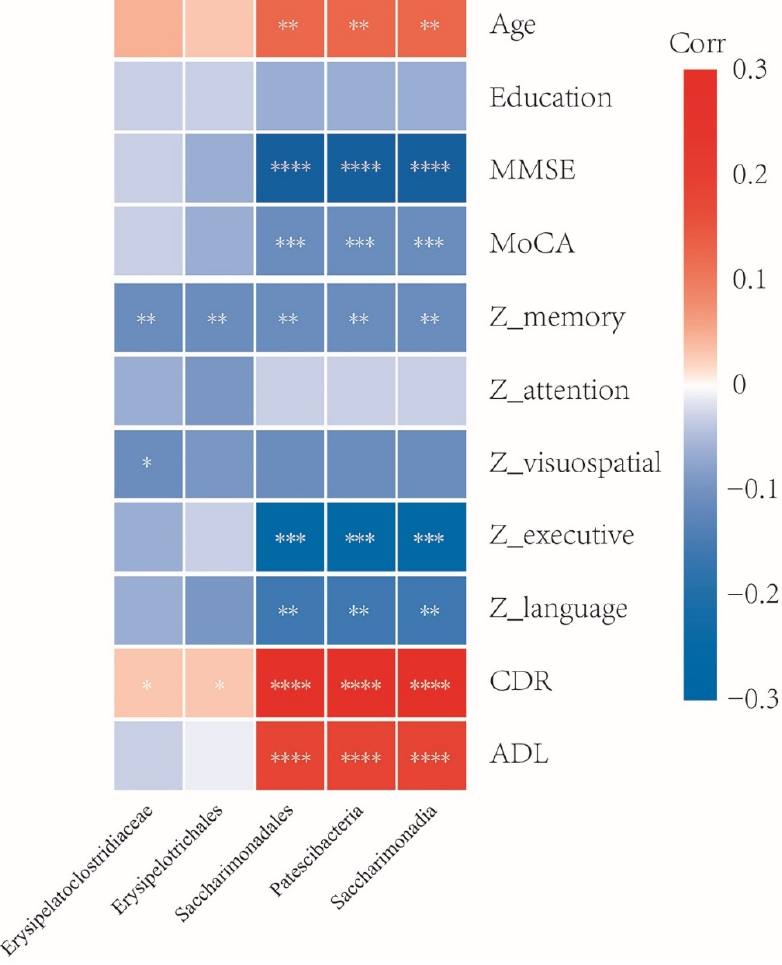
Figure 4. Correlations between the five specific taxa and clinical characteristics. The correlation coefficients (Corr) are displayed. Red or blue signified positive or negative correlation, respectively. MMSE, Mini-mental State Examination; MoCA, Montreal Cognitive Assessment; ADL, Activities of Daily Living; CDR, Clinical Dementia Rating; The composite Z scores were computed for specific cognitive domains including memory, attention, visuospatial ability, language, and executive func- tion. * p < 0.05, ** p < 0.01, *** p < 0.001, **** p < 0.0001.